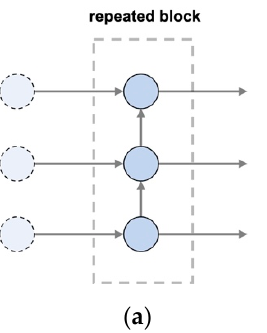
Figure 11. ( a ) The structure of FPN; ( b ) the structure of PANAT; ( b ) the structure of